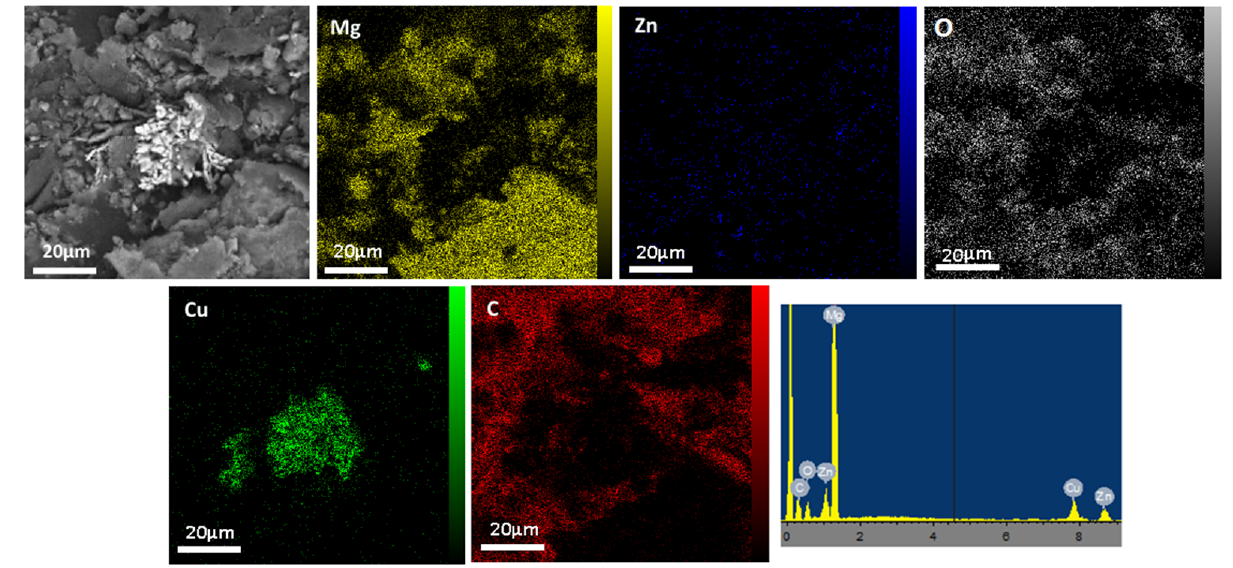
Figure 4. SEM, EDX, and map images of MZ/2GO-Cu powder composites.